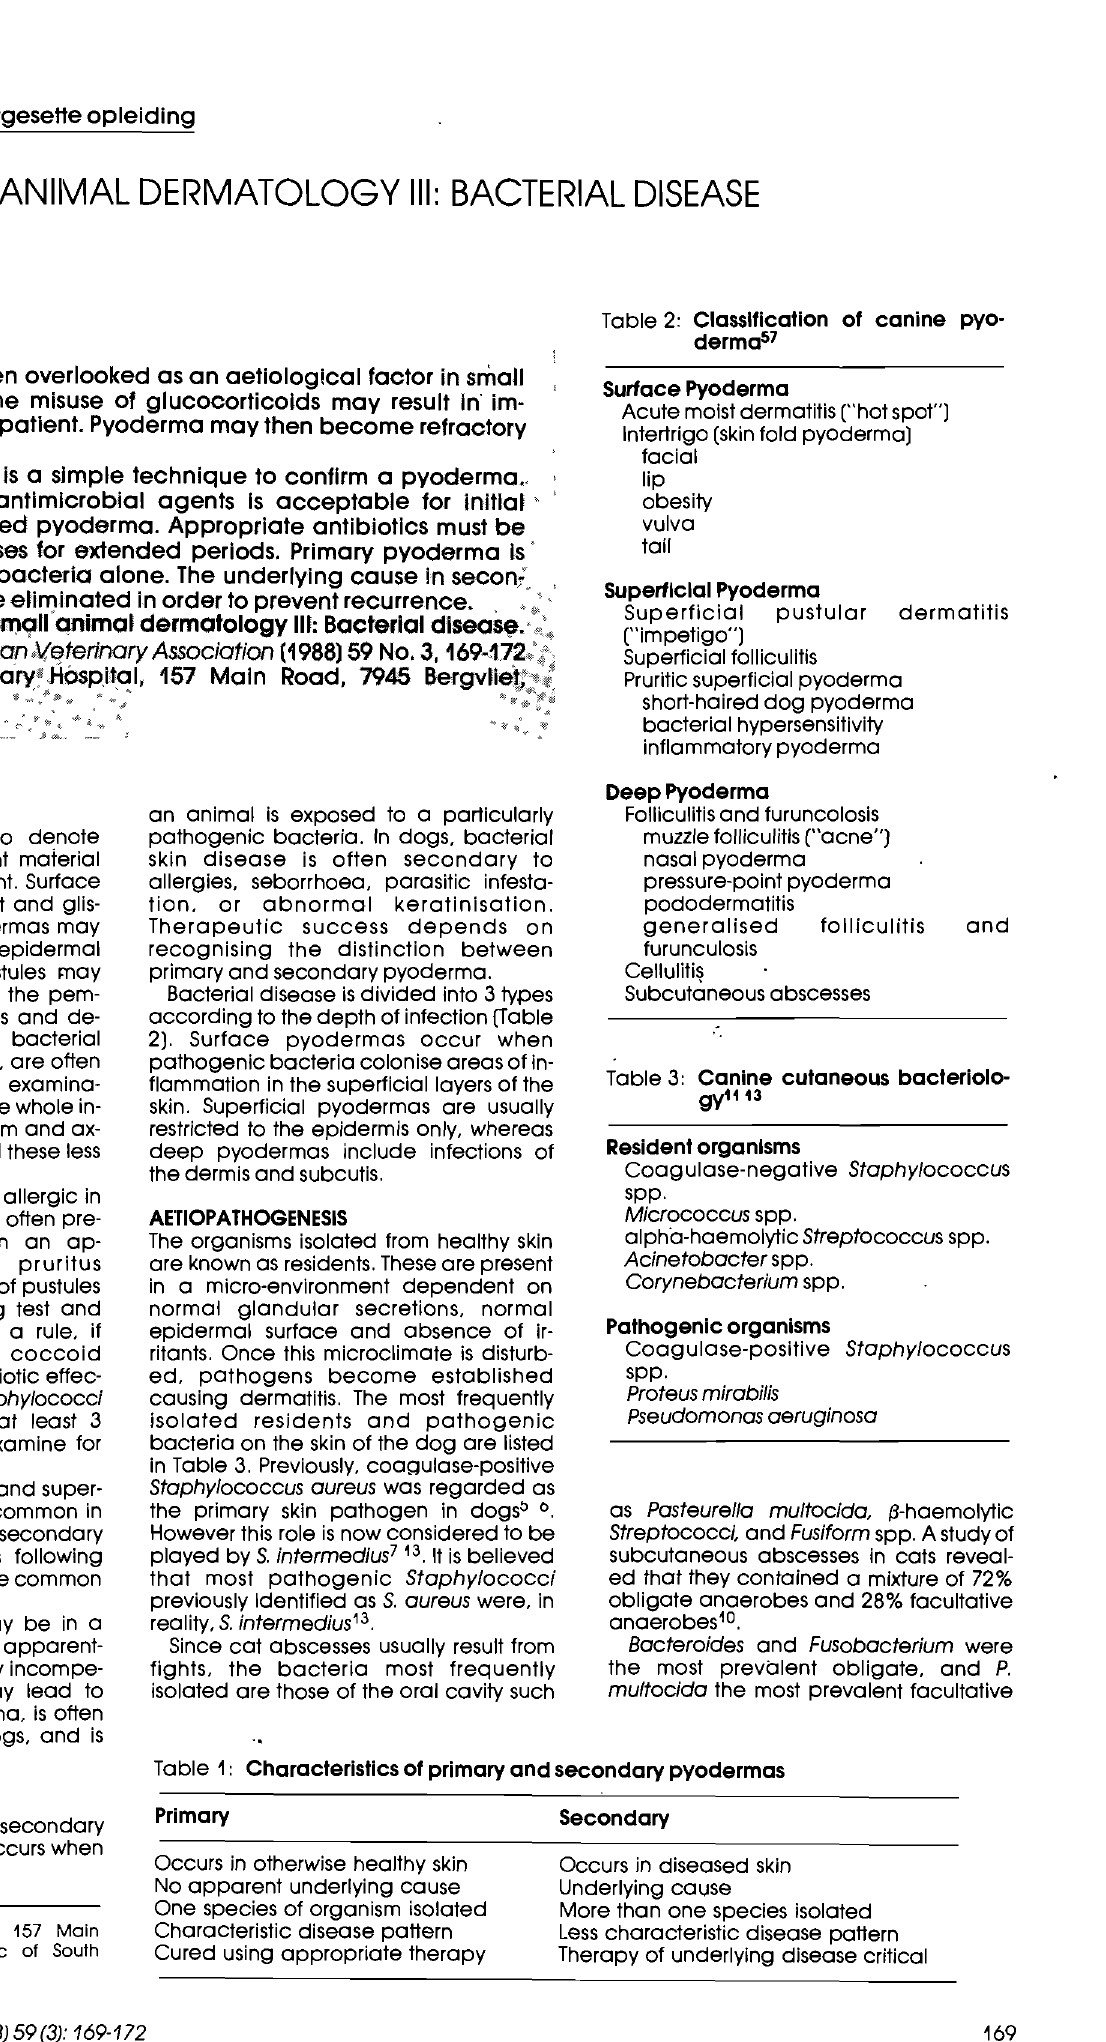
Table 1: Characteristics of primary and secondary pyodermas